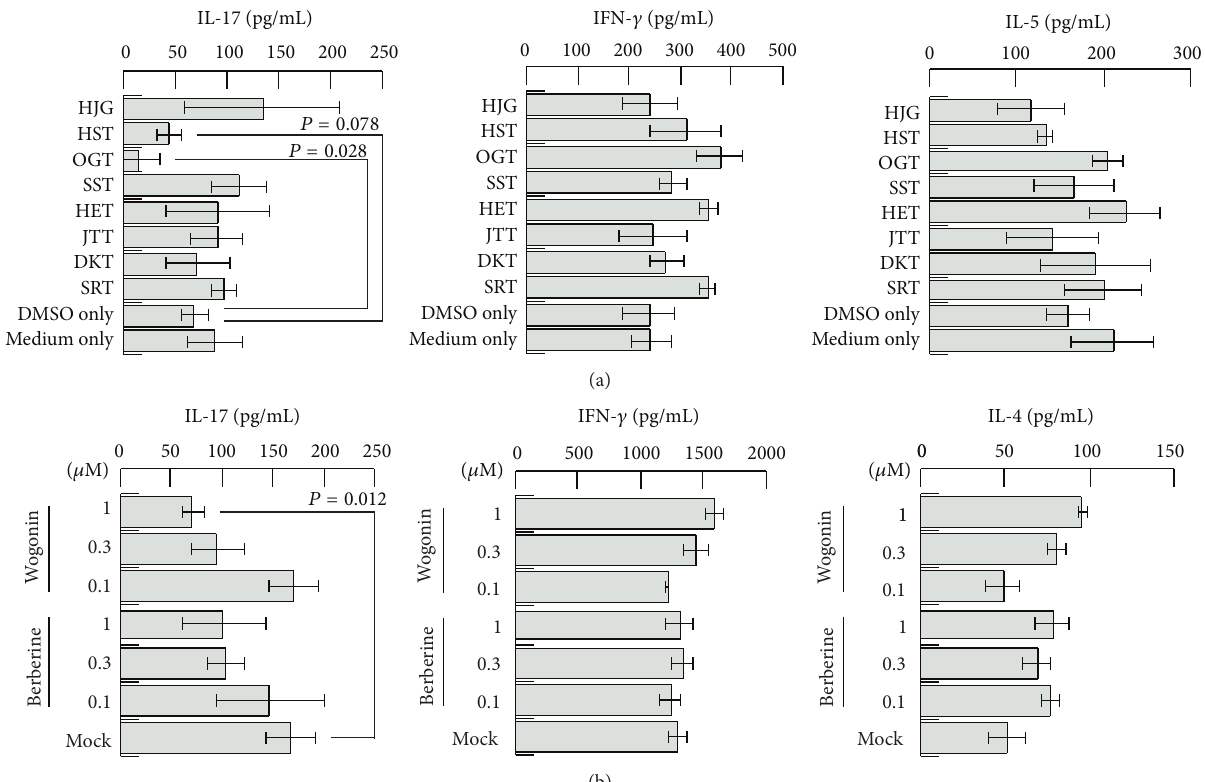
Figure 1: Screening of Kampo extracts and identification of major components that exhibit the inhibitory effects of IL-17 secretion. HJG, HST, OGT, SST, HET, JTT, DKT, or SRT were added at a concentration of 10 𝜇 g/mL to the two-way MLR of splenic lymphocytes obtained from BALB/c and SJL mice and then were incubated for seven days (a). The supernatants were analyzed using ELISA to detect the typical cytokine secretions of IFN- 𝛾 ( center ), IL-5 ( right ), and IL-17 ( left ) for Th1, Th2, and Th17, respectively. Increasing concentrations of wogonin or berberine (0.1, 0.3, and 1 𝜇 M) were mixed with a culture of lymphocytes obtained from BALB/c and SJL mice and then incubated for seven days (b). The supernatants were analyzed using ELISA to detect the typical cytokines of IFN- 𝛾 (center), IL-4 (right), and IL-17 (left) for Th1, Th2, and Th17,